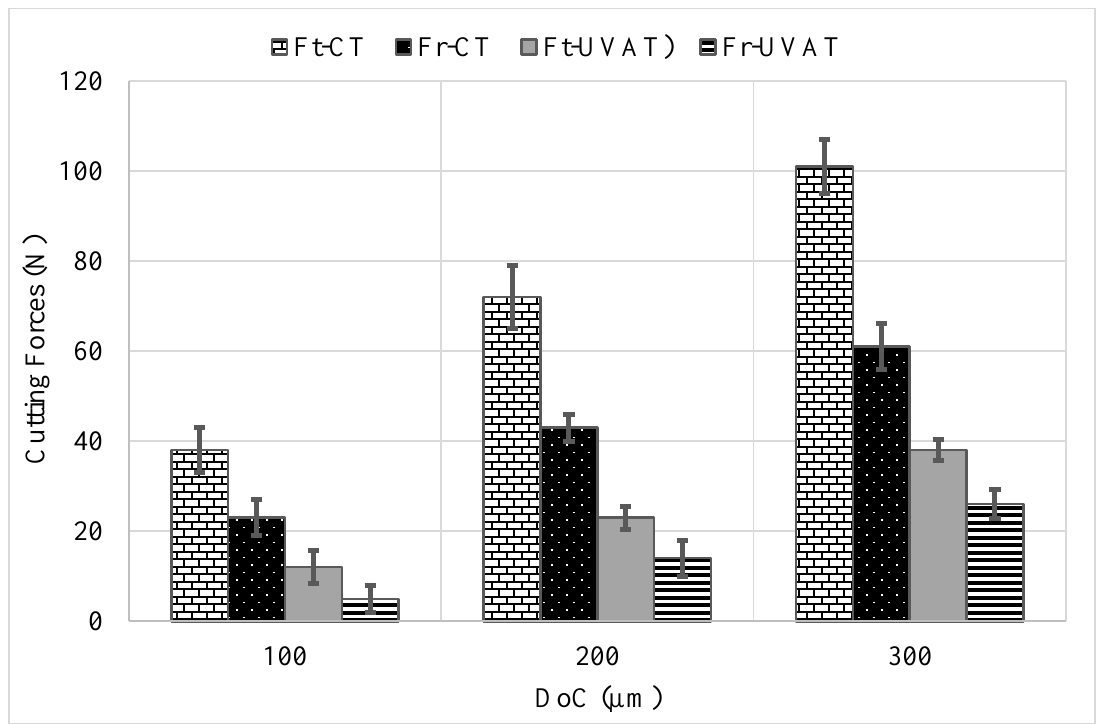
Figure 11. Cutting forces at various DoCs and constant speed of 10 m/min. The cutting forces were measured at various cutting speeds in CT, and it was found that speed has no significant effect on it (see Figure 12). However, in the UVAT process, a gradual increase in Ft and Fr was recorded with an increase in cutting speed. The Ft merely increased from 38 to 54 N when the speed was increased from 10 to 30 m/min and DoC = 300 µ m. The same trend was also seen at lower